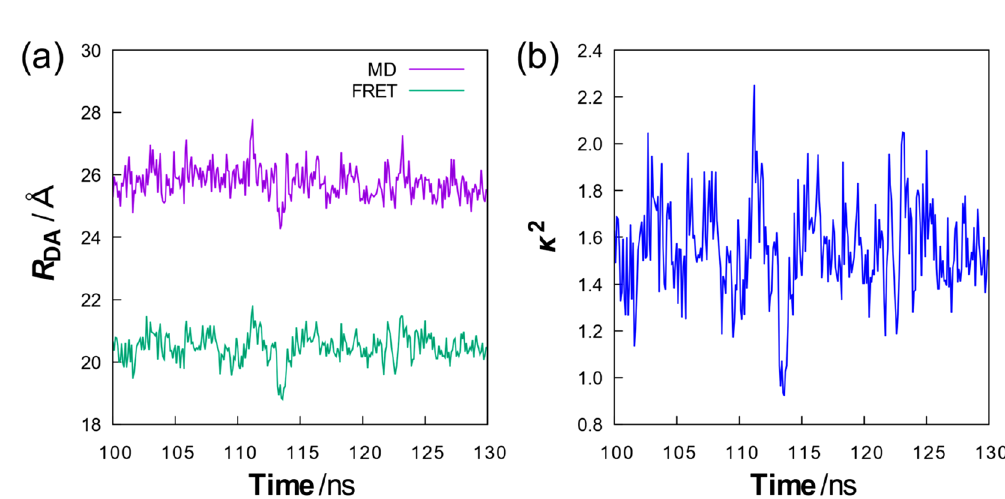
Figure 3. Intermolecular distances and orientation factors as a function of time. ( a ) A647-BChl1 distances R DA obtained from MD simulation and Eq. (4), ( b ) orientation factors κ 2 obtained from electronic coupling calculations with the TrESP method (Eq.